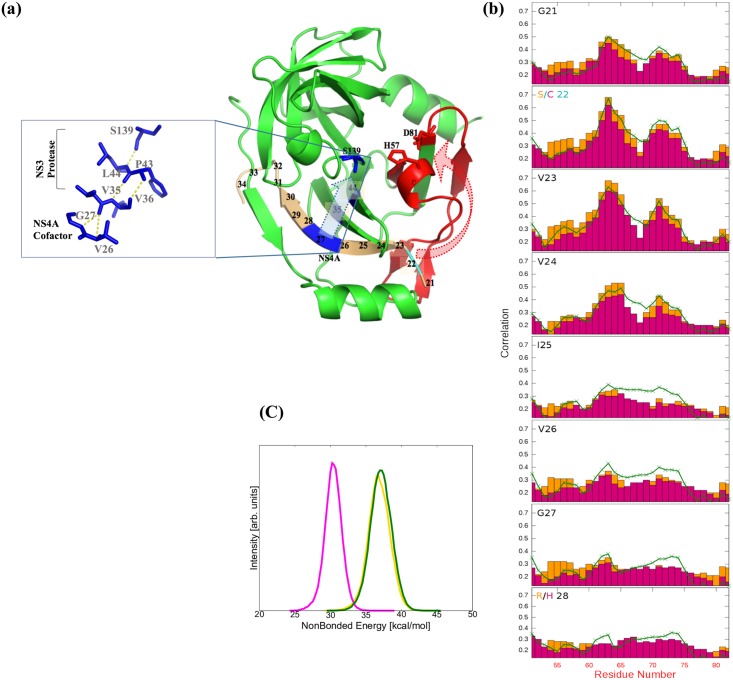
Putative communication pathways from the activation subunit (cofactor binding) to the catalytic subunit in NS3 protease.(a) An overall representative structure of HCV NS3 protease (green), the cofactor is shown in beige. The catalytic subunit (catalytic triad) is highlighted by a dotted ellipse. Inset: hydrogen bonding network between residues 27 and 26 in the NS4A cofactor and anti-parallel beta sheets in the NS3 protease, leading to residue S139 in the catalytic subunit. The red dotted arrow in (a) indicates a putative conformational pathway from site (C223a/S221b, cyan), in the cofactor to the catalytic triad through residues 51–81 (red). The blue dotted arrow in (a) indicates another putative pathway in blue from the NS4A cofactor leading to the catalytic residue S139 through the hydrogen bonding network shown in the inset. (b) Analysis of backbone correlated motions between residues 21–28 in the NS4A cofactor and residues 51–81 [red in (a)] in the NS3 protease. The backbone motion correlations are shown for NS3 proteases for the variants HCV-1b (green), HCV-3a (magenta) and HCV-3a* (gold). The correlation scale is set from 0.0 (for no correlation) to 1.0 (completely correlated). Swapping the 1b NS4A cofactor for the 3a cofactor resorted HCV-1b-like correlation in the variant HCV-3a*, particularly at site (C223a/S221b). Correlation is negligible for other cofactor mutations sites (K343a/R341b), (E303a/I301b) and (H283a/R281b); thus not shown. (c) The non-bonded energy distribution during the course of the simulation, for the cofactor residues S221b, S223a*and C22, following the same color code used in Fig 1b.